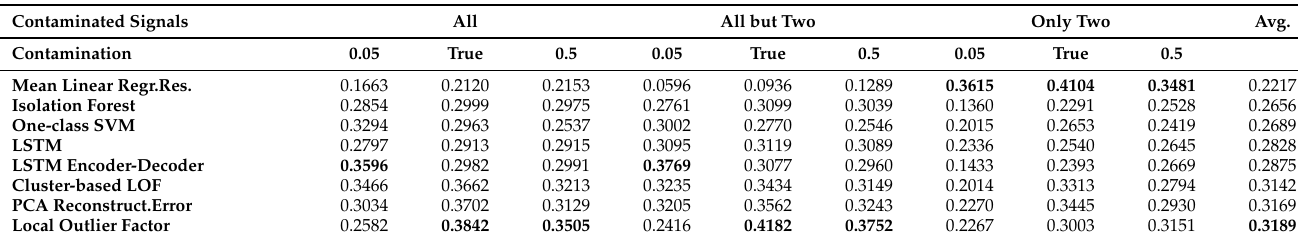
Table 2. Results from experiment EF4 showing the F 0.5 score for the facade dataset when thresholding using different contamination values and injecting artificial anomalies into different sets of signals. Contaminated Signals All All but Two Only Two Avg. Contamination 0.05 True 0.5 0.05 True 0.5 0.05 True 0.5 Mean Linear Regr.Res.